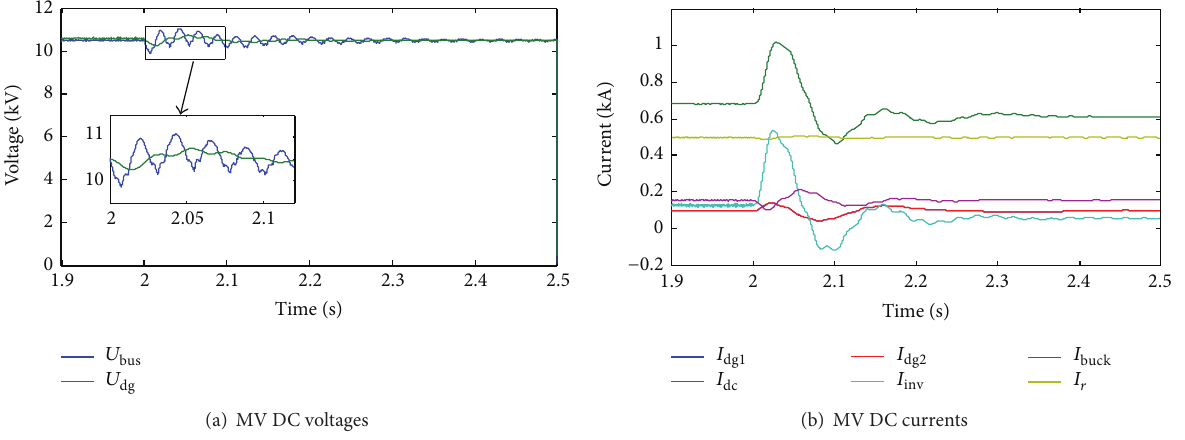
Figure 13: Transient response waveforms of fault